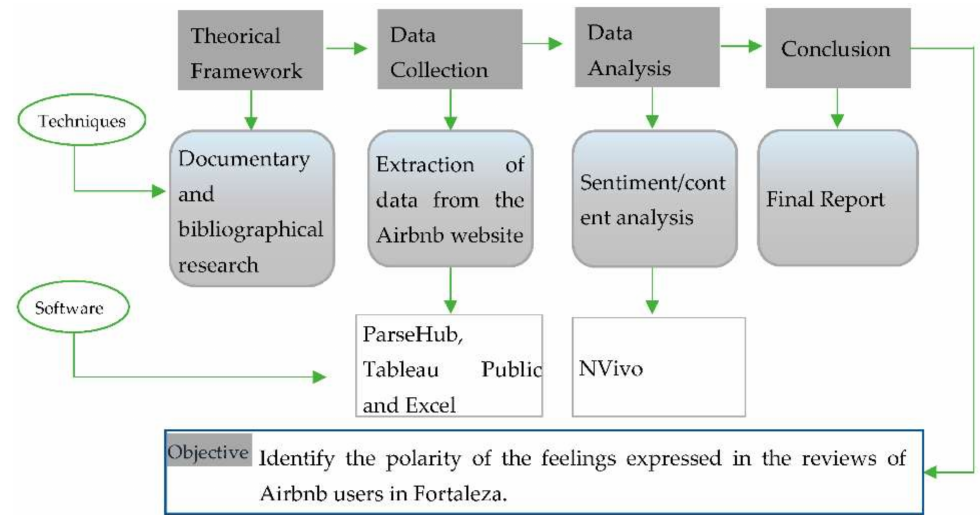
Figure 1. Sentiment analysis